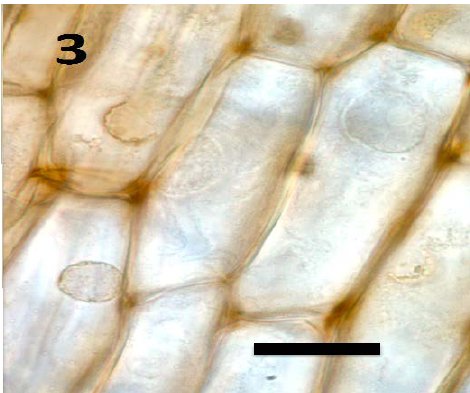
Figure 3. Root parenchyma cells of axenic tomato seedling showing absence of bacteria in cells (bar = 25 µm; stained with 3,3-diaminobenzidine followed by aniline blue).